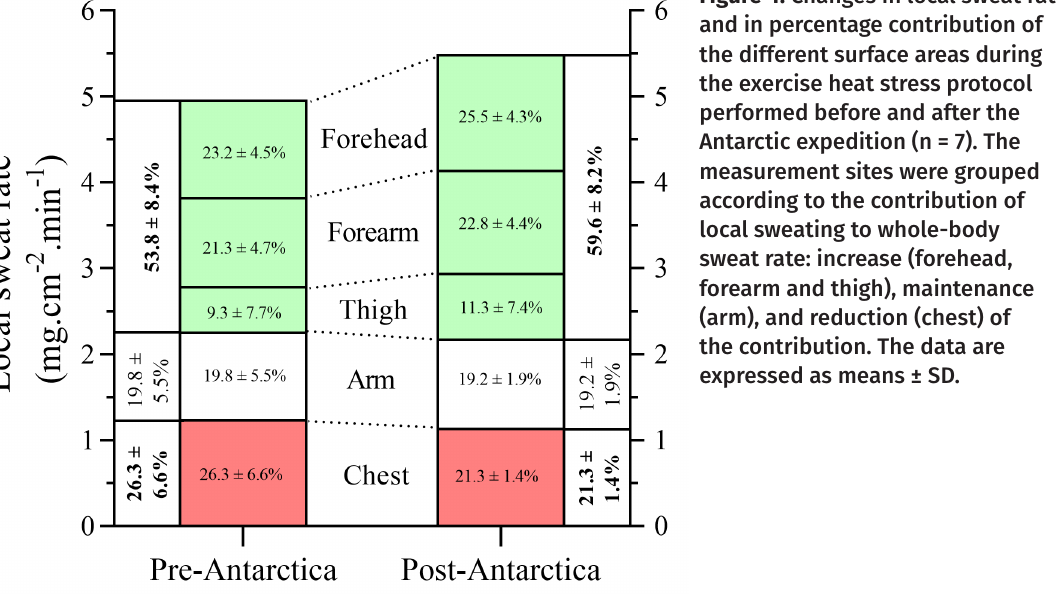
Figure 4. Changes in local sweat rate and in percentage contribution of the different surface areas during the exercise heat stress protocol performed before and after the Antarctic expedition (n = 7). The measurement sites were